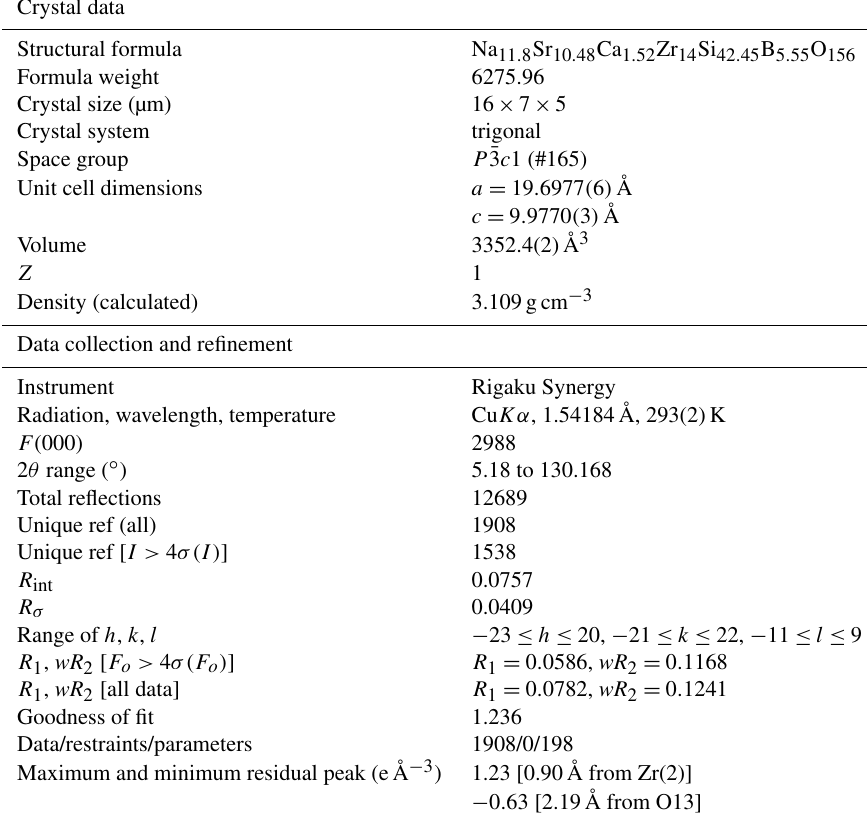
Table 2. Crystallographic data and refinement results for